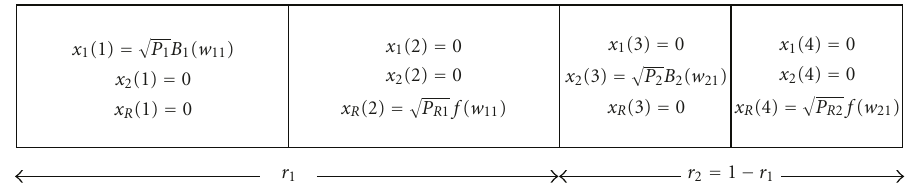
Figure 2: One frame of the considered orthogonal cooperation scheme for the case of 2 source nodes, and its constituent subframes.